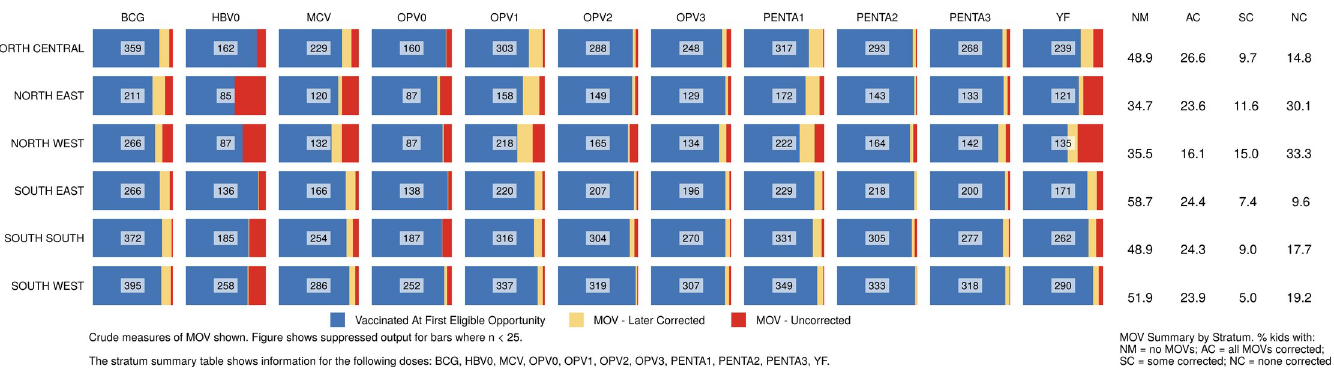
PLOS ONE | https://doi.org/10.1371/journal.pone.0247415 February 26,